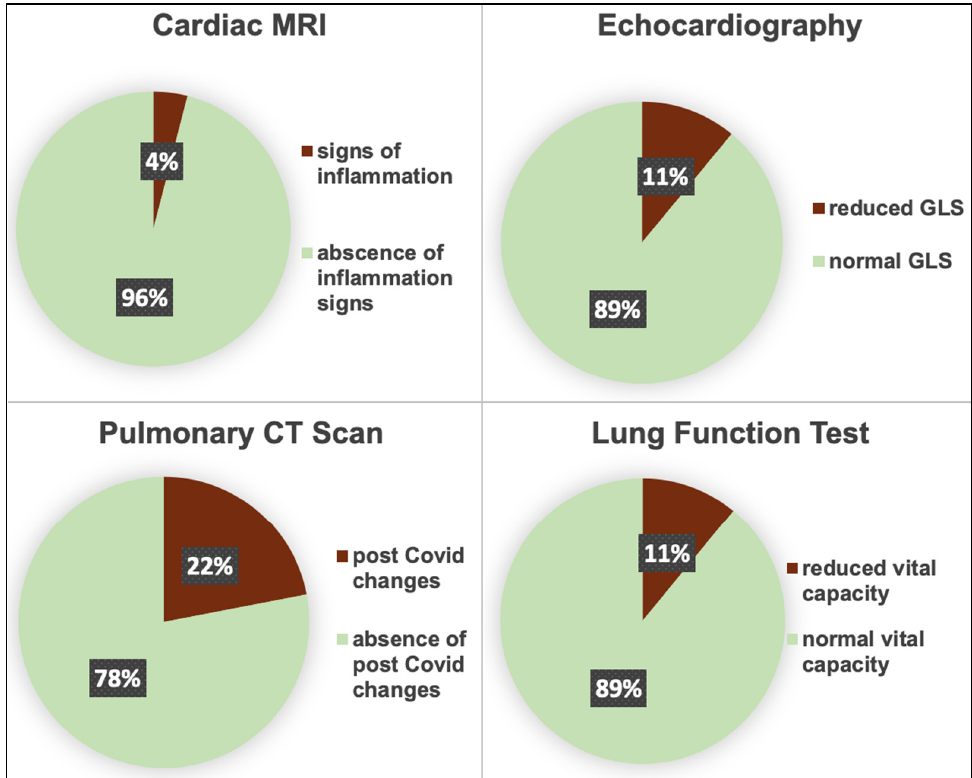
Figure 2. Cardiac and pulmonary structural and functional changes 6 months post COVID-19. MRI, magnetic resonance imaging; GLS, global longitudinal strain; CT, computed tomography. Table 2. Imaging parameters of the 150 study participants 6 months post COVID-19 disease.